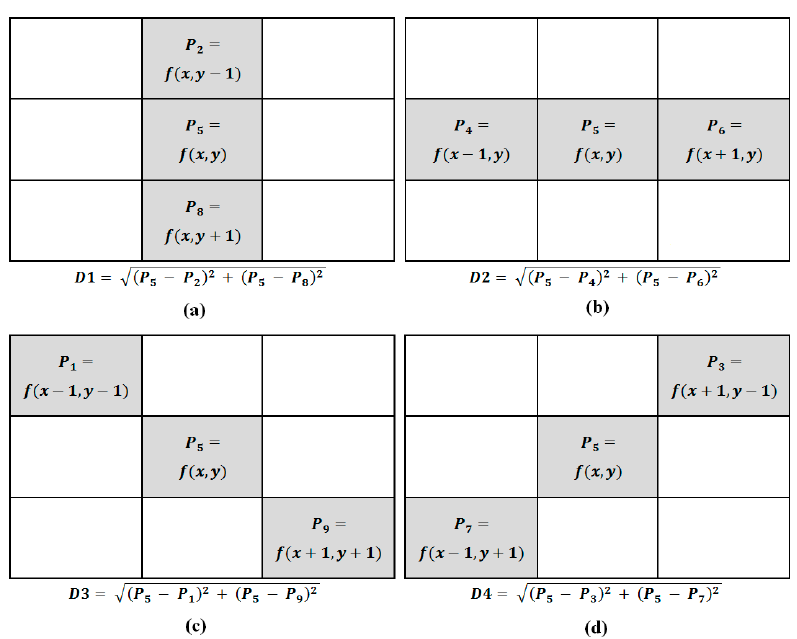
Figure 2. Matrix position.